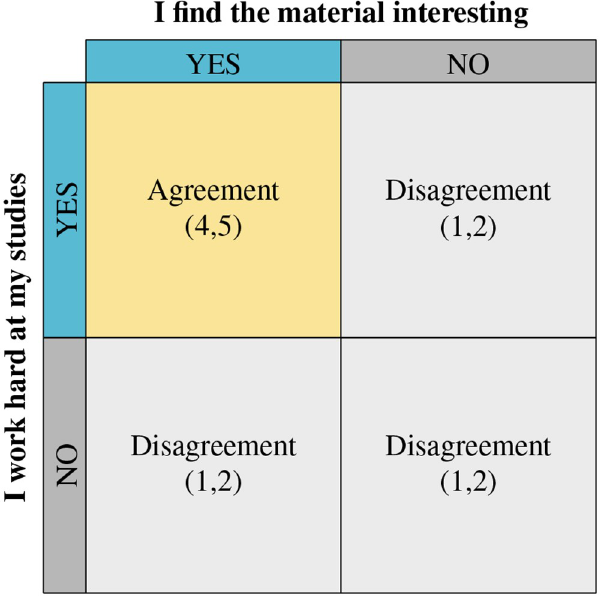
Fig 2. Diagrammatic representation of agreement or disagreement between interview responses and R-SPQ-2F responses for compound items.